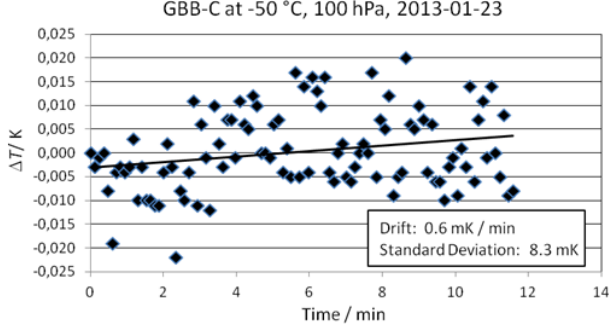
Fig. 13. Short-term stability of the radiation temperature of the GLORIA blackbody GBB-C at − 50 ◦ C and 100hPa observed in the middle of the optical surface.